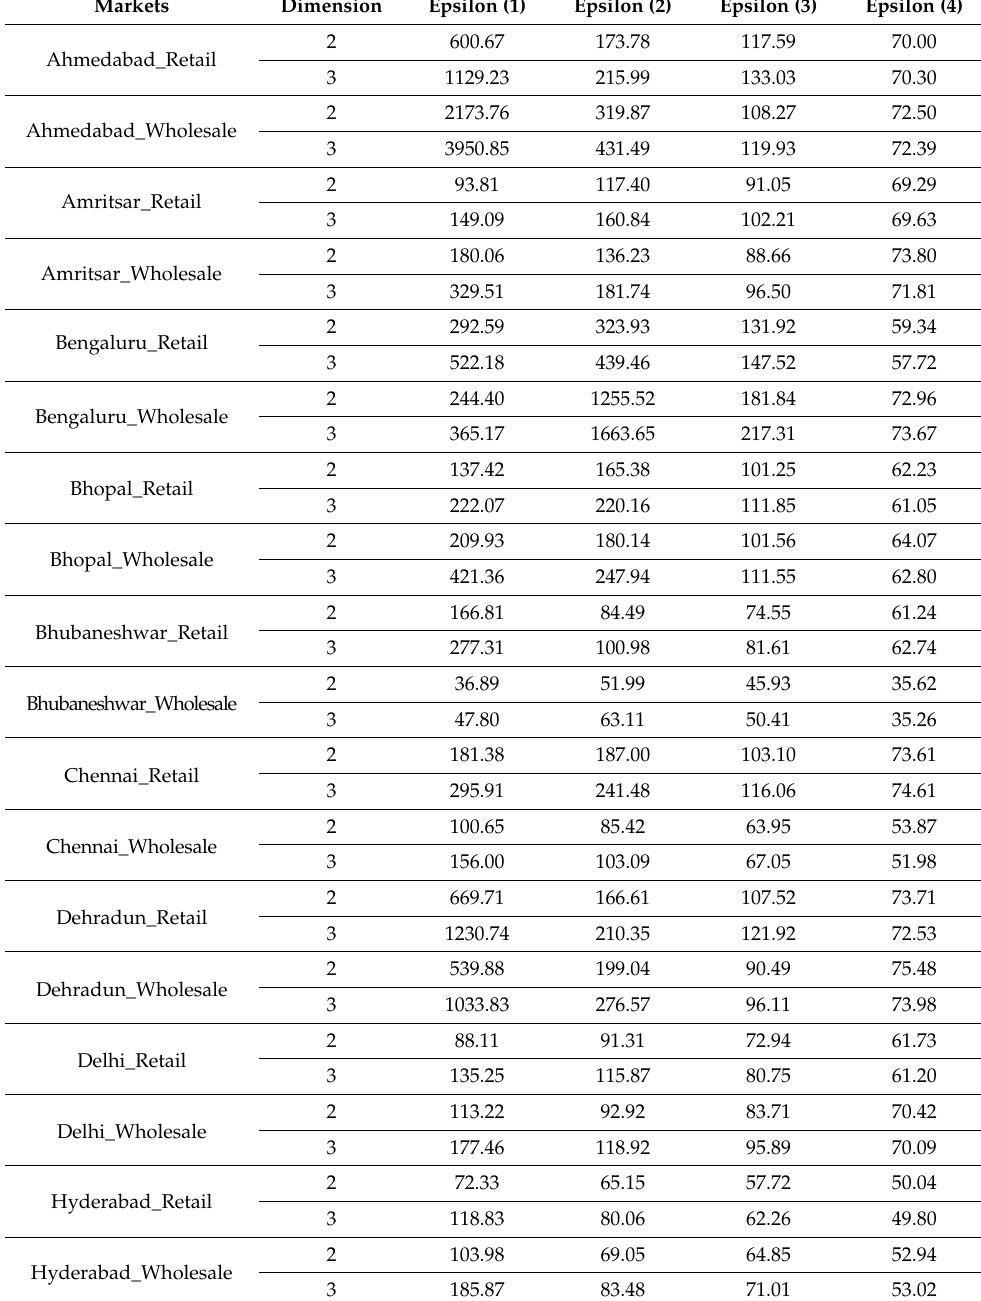
Table 5. BDS test to test the nonlinearity in each of the price series.